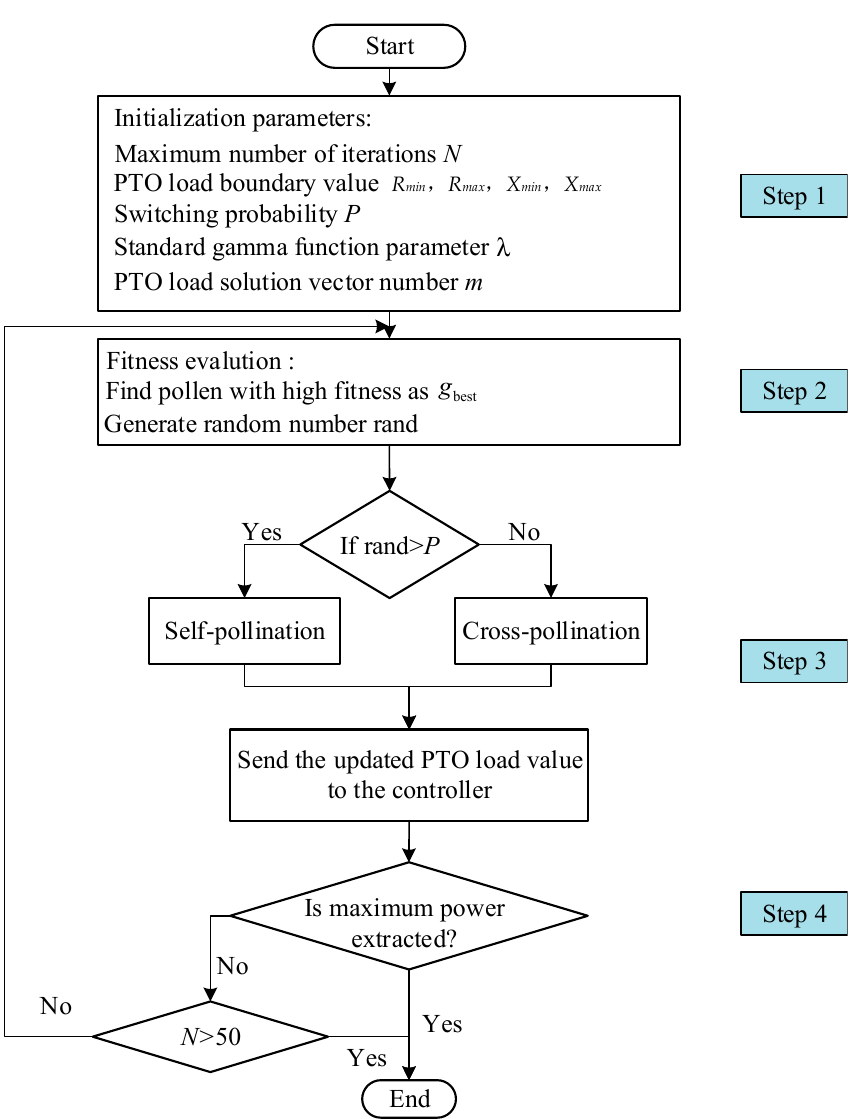
Figure 6. Flow chart of maximum power point tracking (MPPT) control algorithm for point-absorbing type WEC based on flower pollination algorithm (FPA).